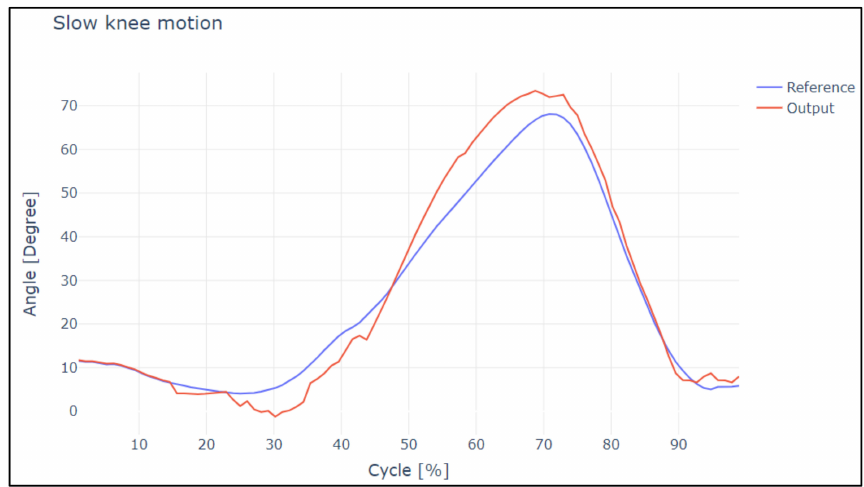
Figure 14. Reference curves vs. output during slow knee